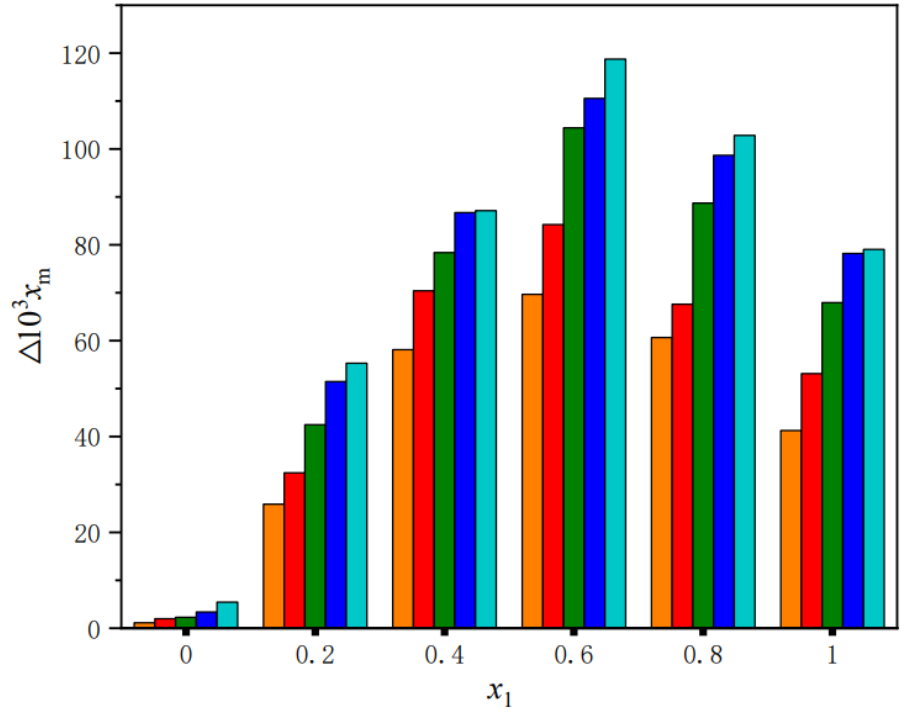
Figure 5. The mole fraction solubility difference △ 10 3 x m between FFCA and FDCA in water + 1,4-dioxane solvent mixtures (FFCA solubility – FDCA solubility) at different solvent mixing ratios and different temperatures. Orange = 303.15 K; Red = 313.15 K; Green = 323.15 K; Blue = 333.15 K; Cyan = 343.15 K.